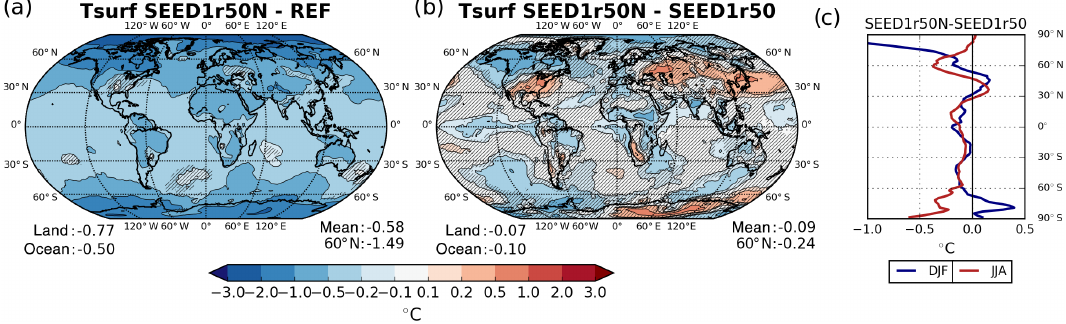
Figure 8. Annually averaged anomalies of surface temperature (Tsurf) for the SEED1r50N simulation with respect to REF (a) or SEED1r50 (b) . The hatching is applied for anomalies not significant at the 95% confidence level. Panel (c) shows the respective annual zonal average anomalies of SEED1r50N with respect to SEED1r50 for DJF (blue) and JJA (red). All simulations are performed in the MLO